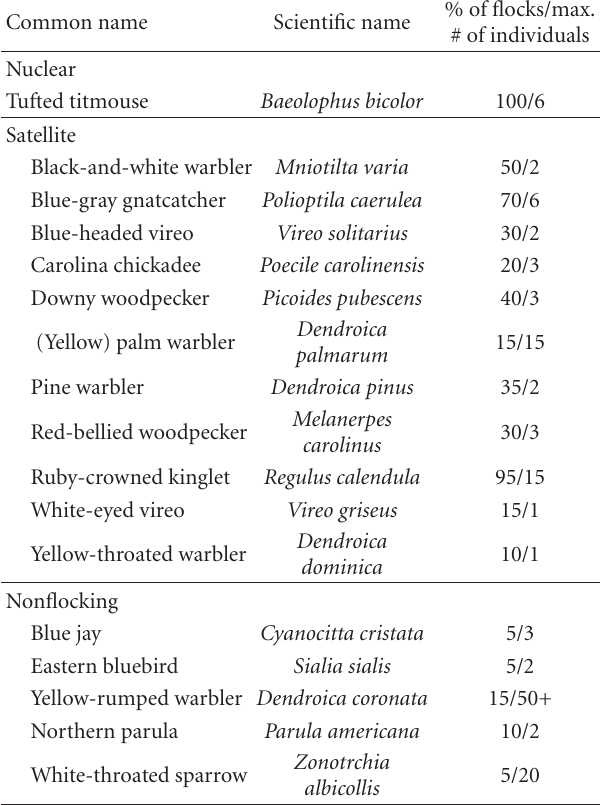
Table 1: All species encountered in mixed-species flocks during the study (classified into flock roles (nuclear, satellite, or nonflocking) based on Farley et al. [4]). Percentage of flocks is the percentage of the 20 flocks where the species was encountered at a minimum of one observation point. Max. number of individuals is the estimated maximum number of individuals in a flock observed at one